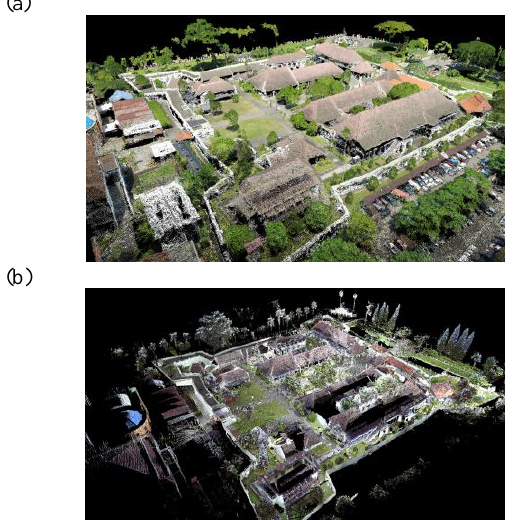
Figure 10. 3D pointclouds at VFM from UAV photogrammetry (a) and TLS measurement (b).